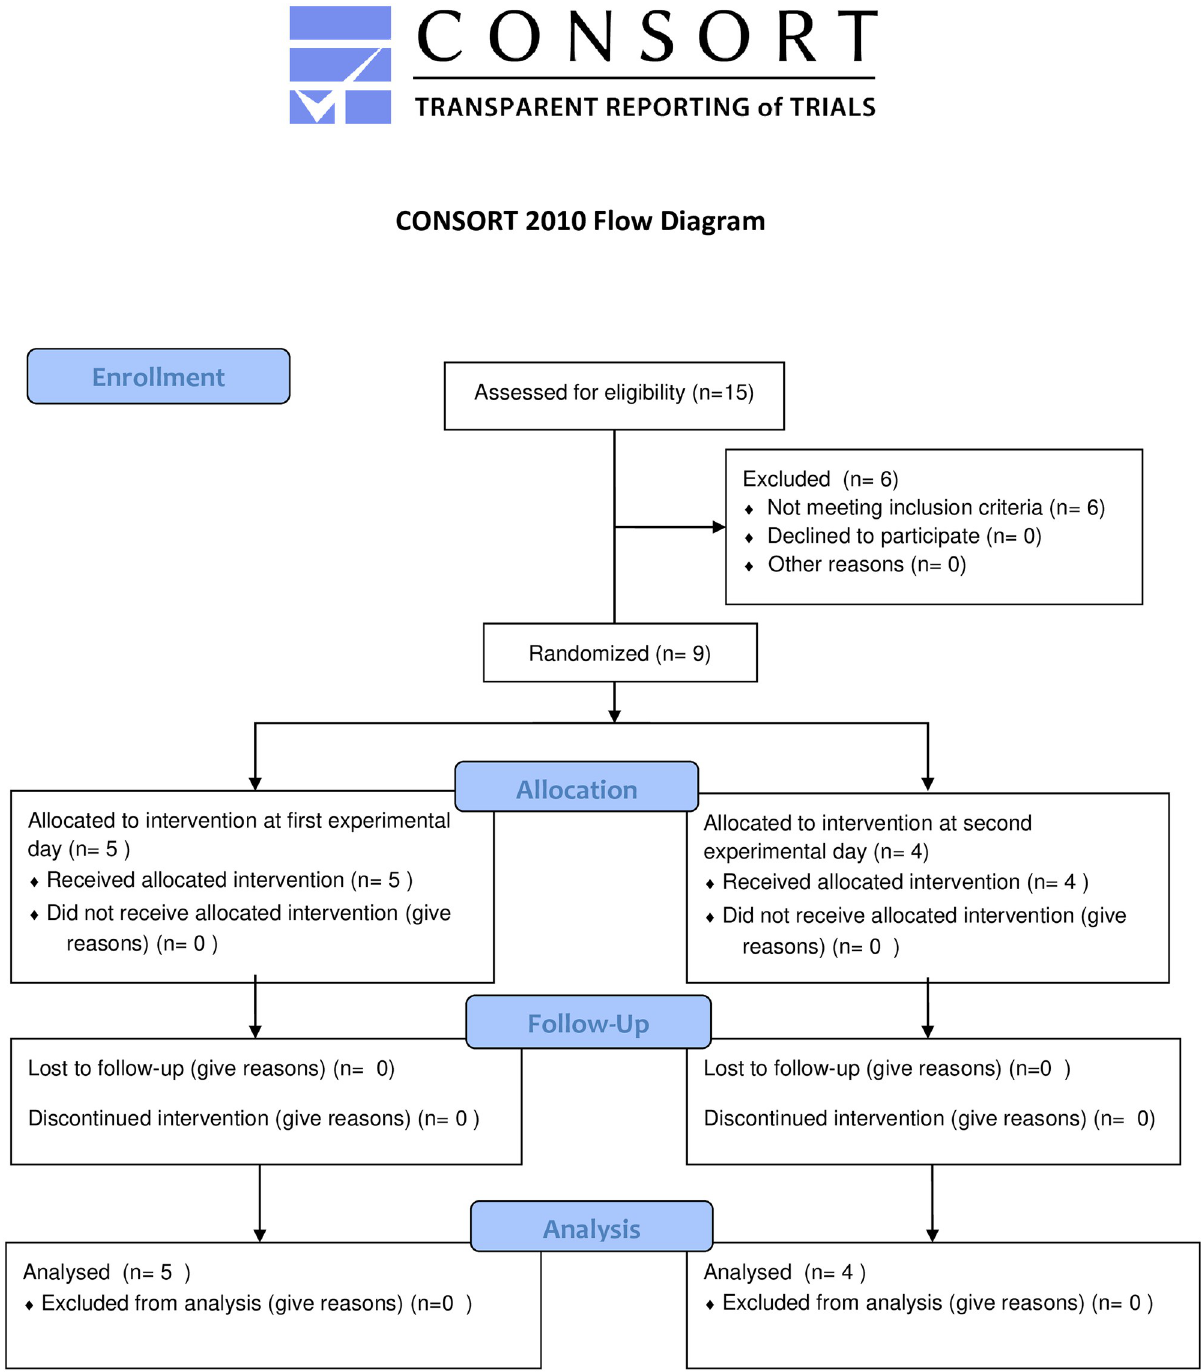
Fig 1. A schematic example of the pupillometry measurement. The figure shows a normal pupillometry. The mean pupillary diameter was normalized against the mean baseline pupil diameter. The pupils were video recorded for 10 seconds before light stimulation, 20 seconds during light stimulation called “Light ON” (blue arrow), and 40 seconds after light stimulation called “Light OFF” (black arrow). Early PIPR (light grey area) is the early post-illumination pupillary response recorded 0–10 seconds after the light turns off. Late PIPR (dark grey area) is the late post-illumination pupillary response (late PIPR) recorded 10–30 seconds after the light turns off